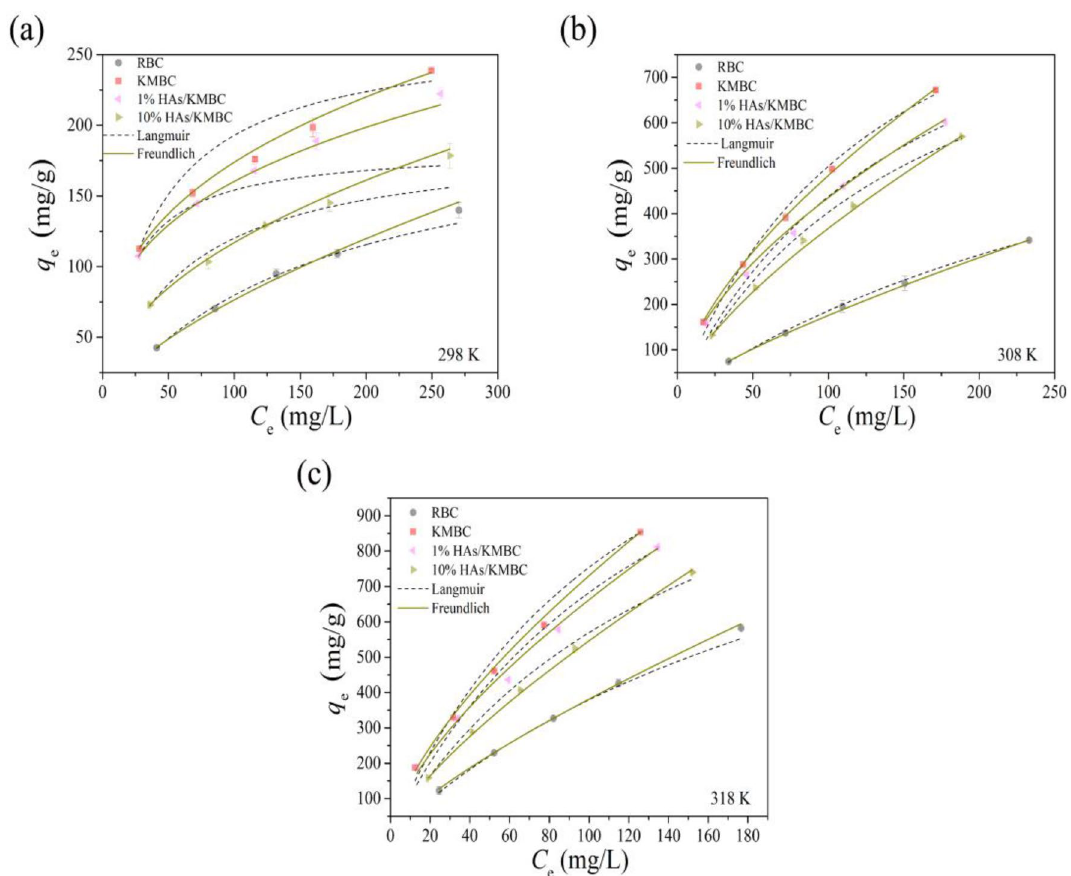
Figure 4. Effects of TC concentration and temperature [( a ):298 K; ( b ):308 K; ( c ):318 K] on TC adsorption by RBC, KMBC, 1% HAs/KMBC and 10% HAs/KMBC. m / V = 0.1 g/L, t = 26 h, pH =